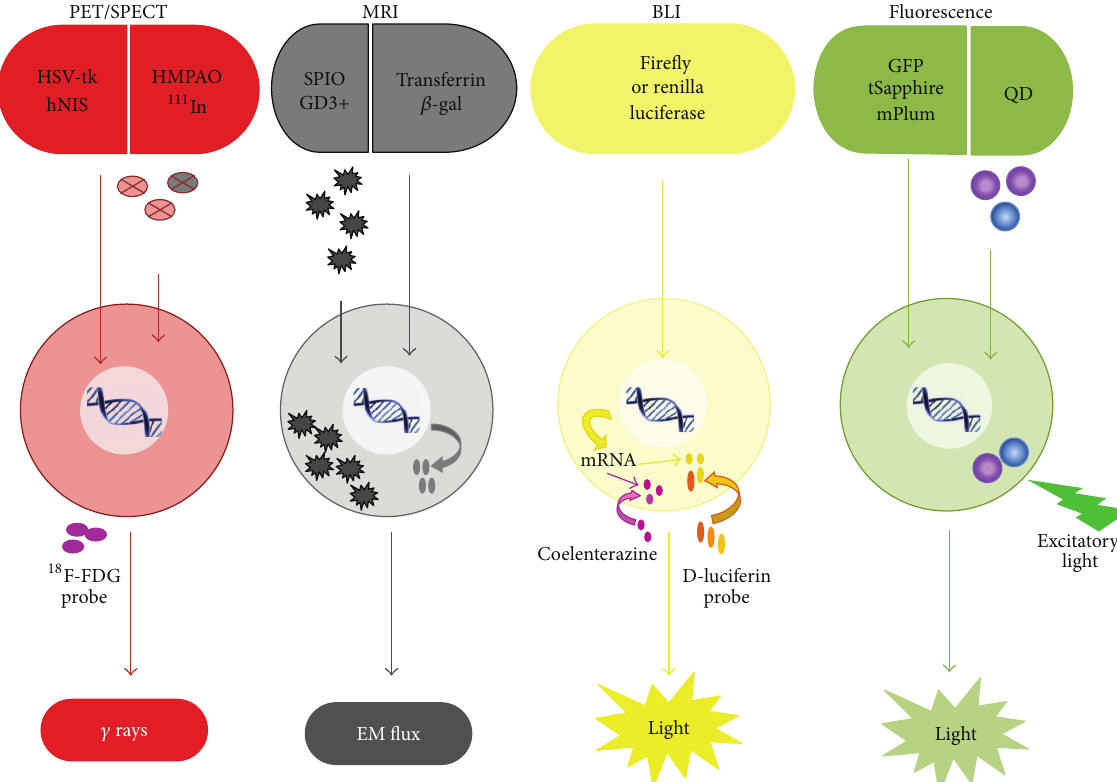
Figure 1: Schematic representation of cell labeling and imaging modalities (reproduced with permission